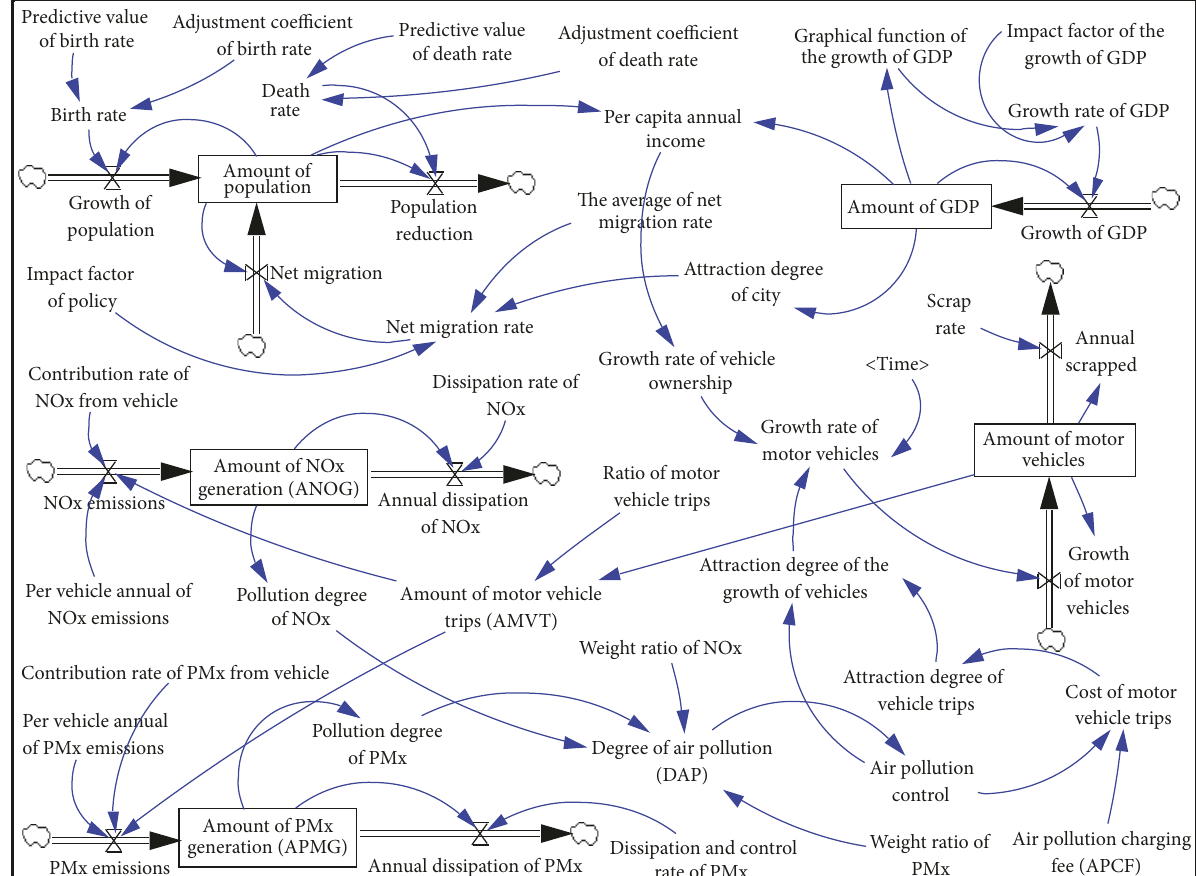
Figure 1: Stock-flow diagram of the motor vehicle pollution charging management model.